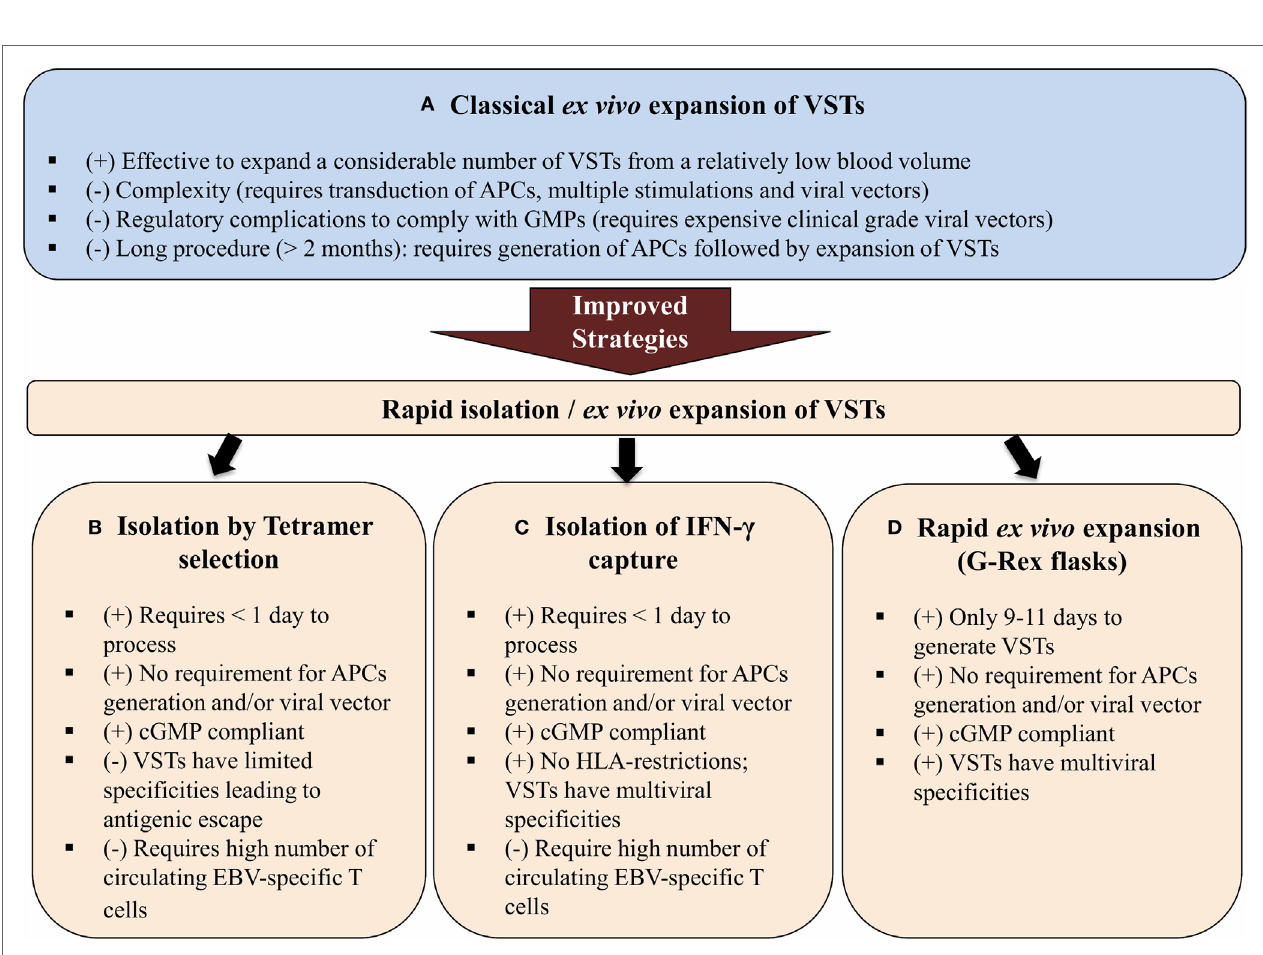
FiGURe 2 | Schematic diagram showing three different improved strategies for the isolation and expansion of VSTs (B–D) over the classical ex vivo expansion of VSTs (A) . Abbreviations: VSTs, virus-specific T cells; APCs, antigen-presenting cells; cGMP, current good manufacturing practices; HLA, human leukocyte antigen; ( + ) and ( − ) are, respectively, for advantages and disadvantages of each